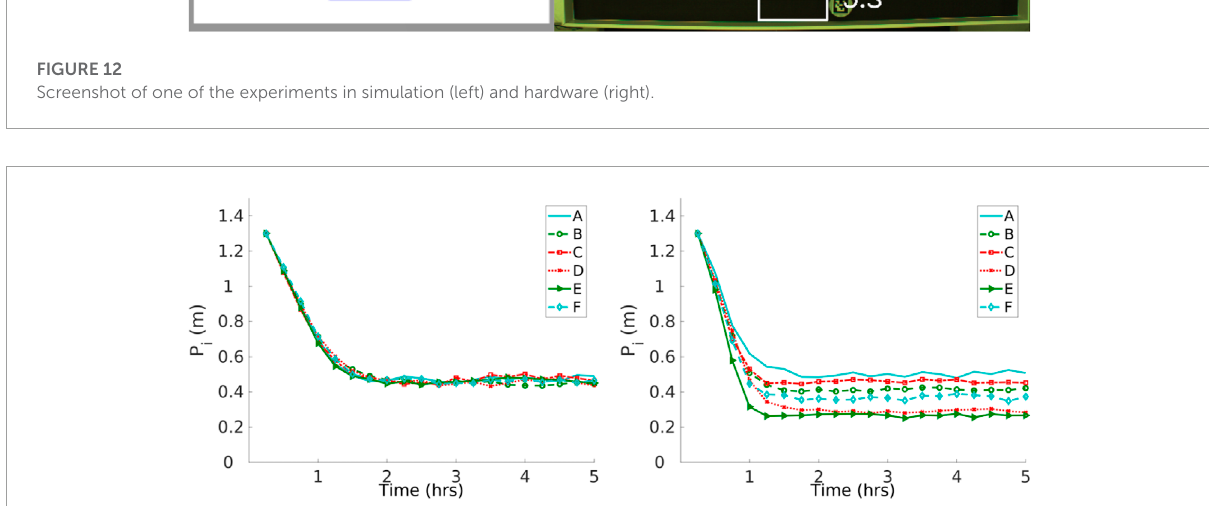
FIGURE 13 Convergence to a solution with homogeneous (left) and heterogeneous (right) errors with the DPS. Robots with the homogeneous error converge to a single P i and robots with the heterogeneous error converge to different P i